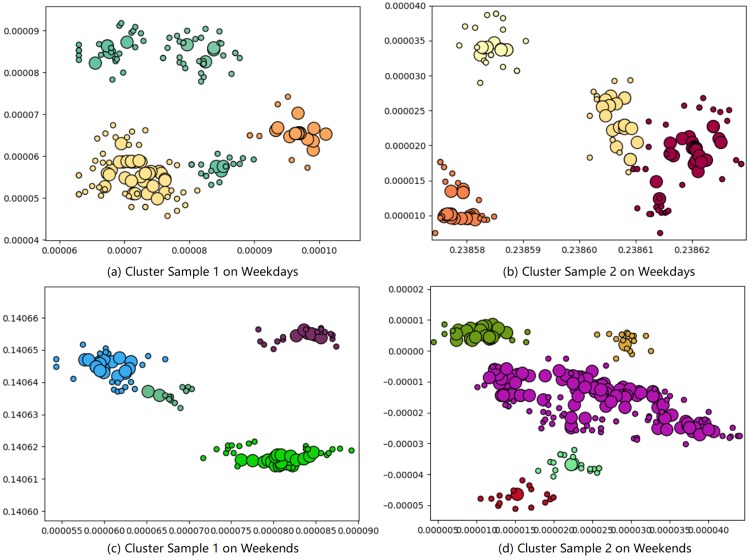
Clustering result sample on weekdays and weekends.